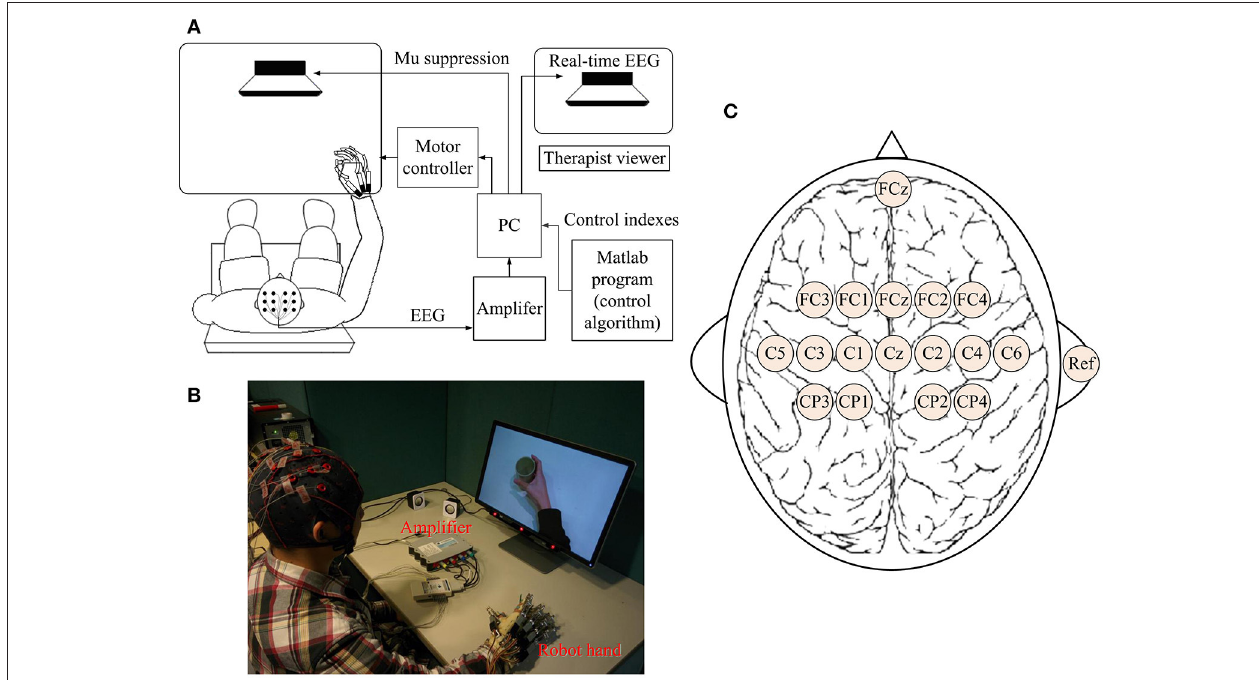
FIGURE 1 | Schematic diagram (A) and real situation (B) of the BCI-motor observation training system for hand training. (C) The location of